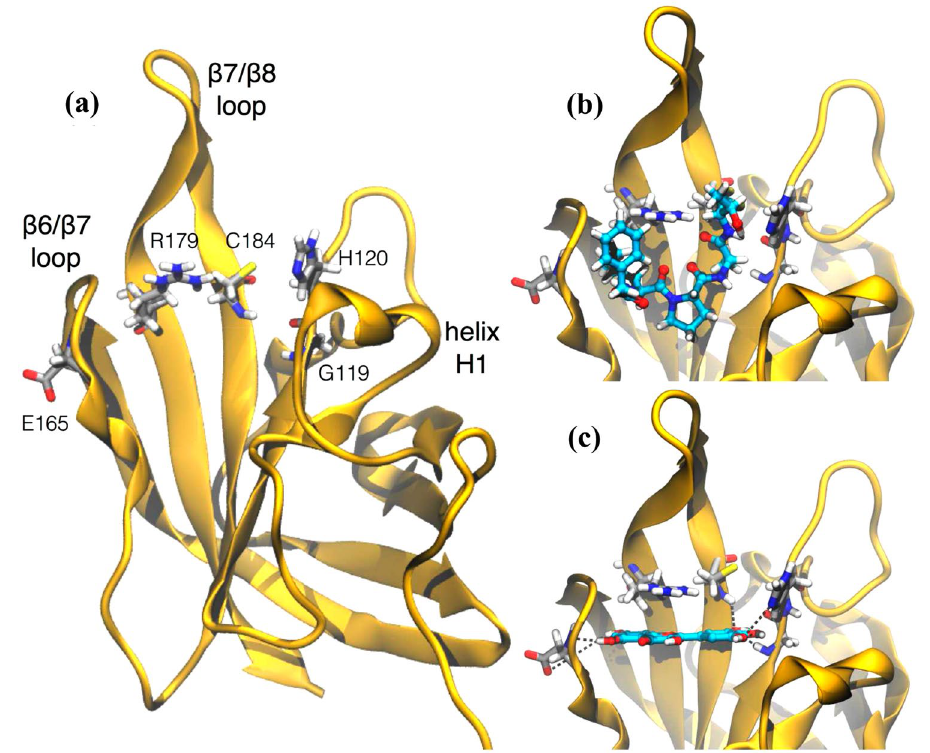
Figure 5. Computational studies of the structural model for the complex Myr-sortase A (SrtA). ( a ) Overall fold of SrtA highlighting regions undergoing large substrate-induced conformational changes. ( b ) Detail of the LPXTG sequence analog covalently bound to SrtA. ( c ) Lowest energy conformation of Myr representative of the lowest energy and most populated conformational cluster obtained through molecular docking calculations. Receptor residues are represented in gray and ligands in cyan. Potential hydrogen-bond interactions are shown in dashed black lines. Methodology can be found in Supplementary